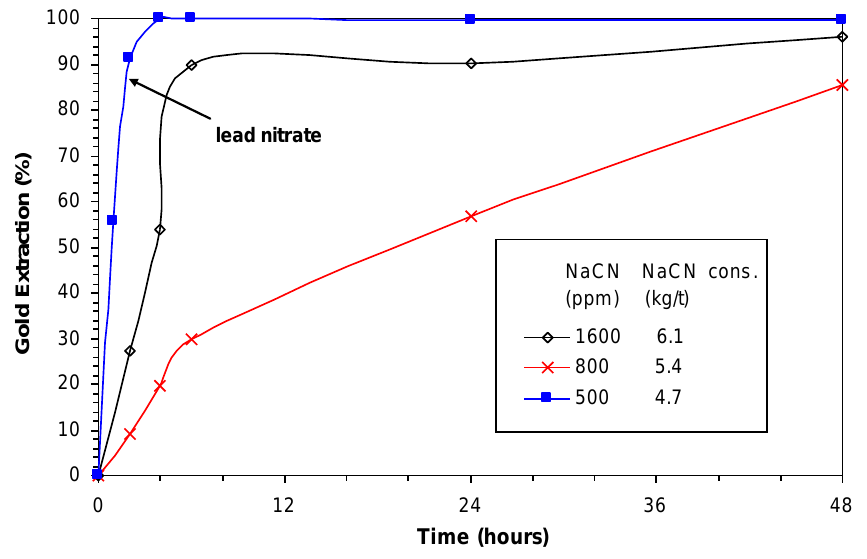
Figure 6. Effect of NaCN concentration and lead nitrate addition on gold extraction in presence of bornite; 0.3% Cu, 8 ppm DO, pH >11.